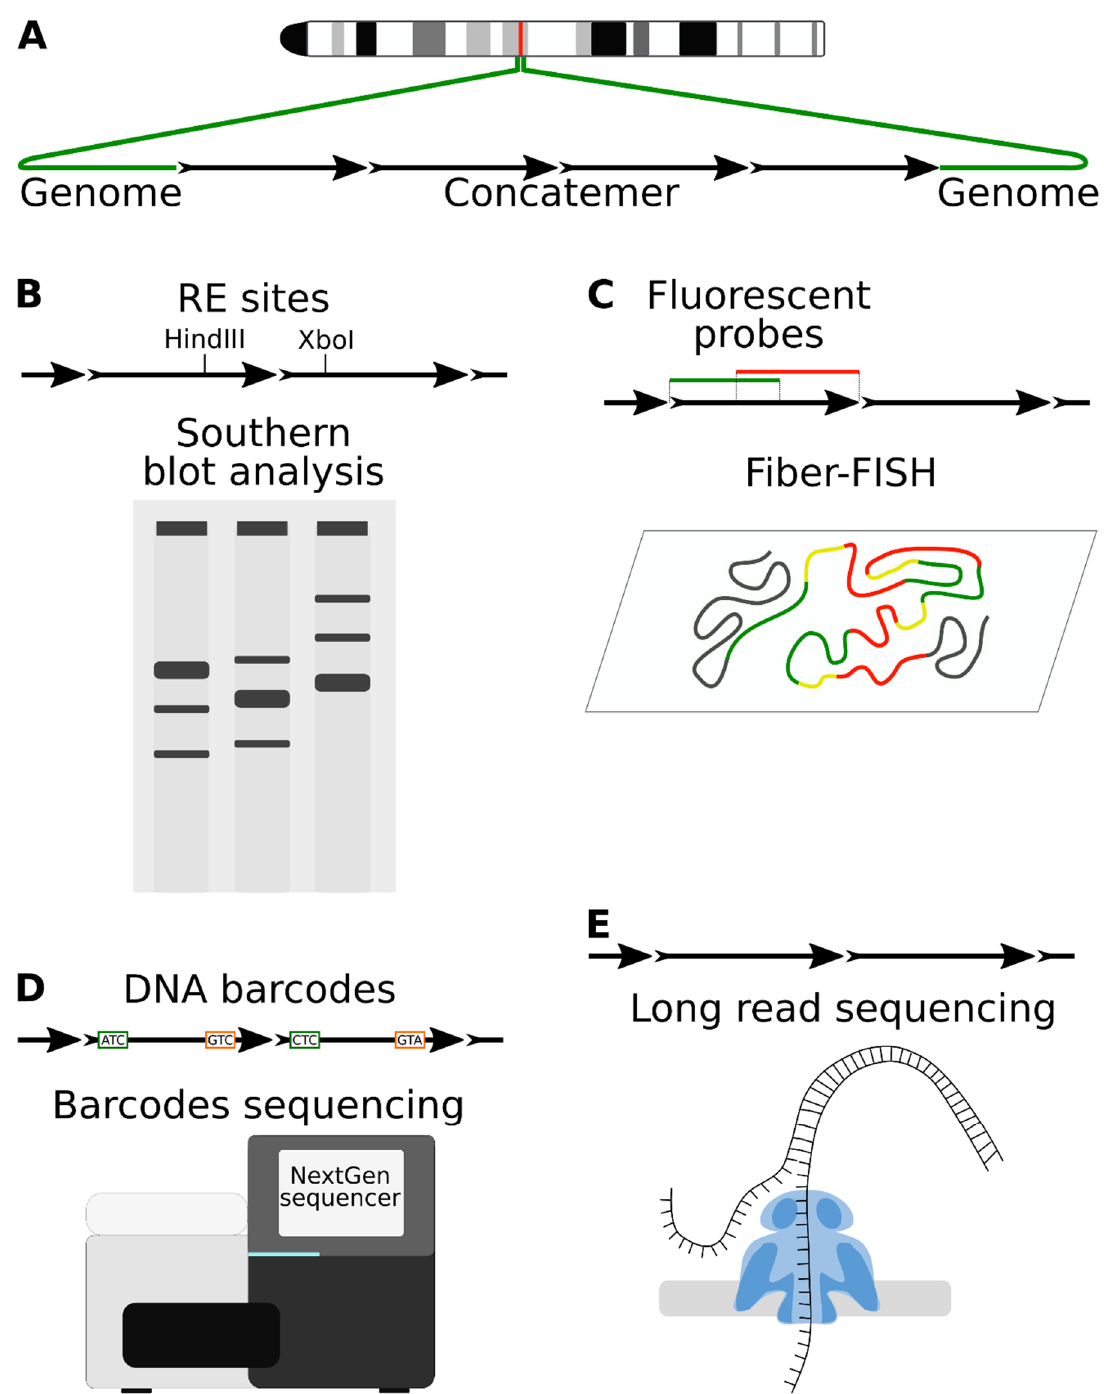
Figure 1. Transgene concatenation and recombination reporters. ( A ) Schematic representation of the concatenated tandem repeat at the chromosomal locus. ( B ) Transgene copies could be labeled with alternative restriction sites to study concatemer by Southern blot. ( C ) FISH analysis on extended DNA fibers demonstrates tandem organization of concatemers. ( D ) Barcoded plasmid library could be used to investigate concatenation. Barcodes from the transgenic copies are amplified with PCR and analyzed by NGS. Connections between barcodes are used to model continuous chains of copies. ( E ) Oxford Nanopore technology, a real-time single-molecule sequencing method, is becoming popular for concatemer analysis.